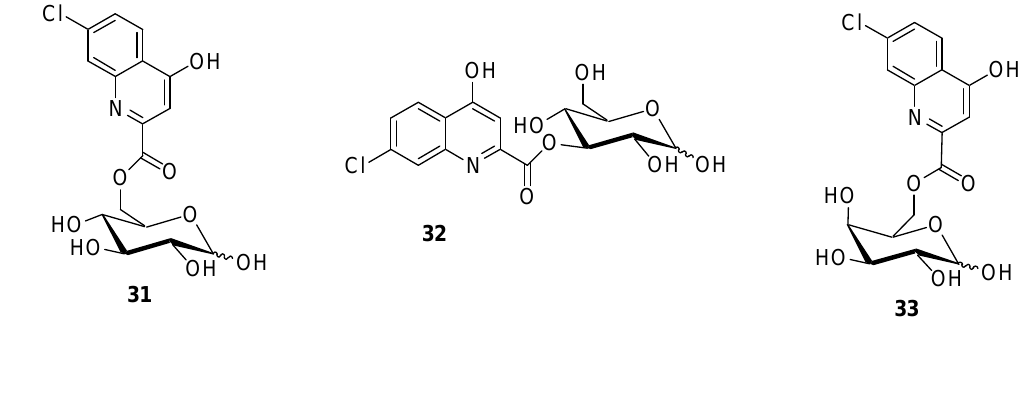
Figure 12: Chemical structures of the glycosyl-conjugates of 7-chlorokinurenic acid (7- Cl-Kyn). The 7-Cl-kyn-glucopyranos-6'-ylester was more potent as anticonvulsant in mice than the 7-Cl-kyn-glucopyranos-3'-ylester. The 7-Cl-kyn-galactopyranos-6'-ylester was not protective in mice against NMDA induced